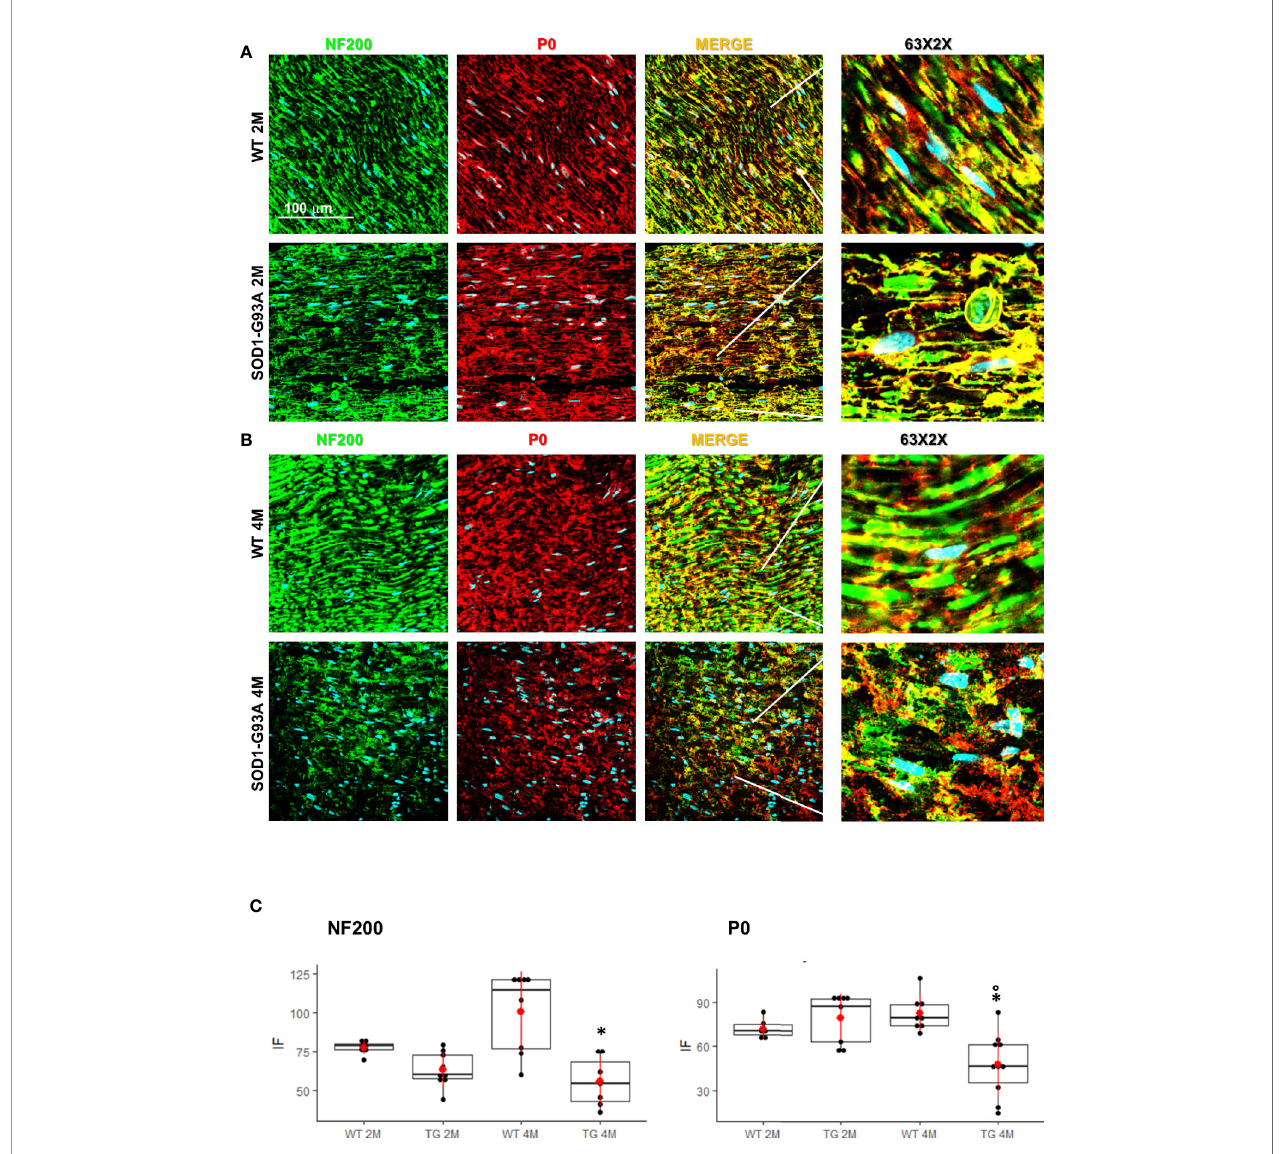
FIGURE 2 | Nerve fi bers degeneration in pre- and symptomatic SOD1-G93A mice. (A) Representative examples of confocal images (magni fi cation 63x) representing morphological changes in structural (NF200 – green) and myelin organization (P0 – red) in 2 (2M) and (B) 4 months old WT and SOD1-G93A mice. The fi gure shows how myelin protein zero (P0, the major component of the myelin sheath with compacting function) and neuro fi lament NF200 (NF200, cytoskeletal marker of myelinated fi bers) are strongly expressed and widely diffused in WT sciatic nerves. (C) RGB analysis of NF200 and P0 in both 2 (2M) and 4 months (4M) old WT and SOD1-G93A (TG) mice. Mean is the red point and +/- SD added as pointrange. (*p <0,05 vs WT; °p <0,05 vs 2M; N = 3/5 group x at least 2 images